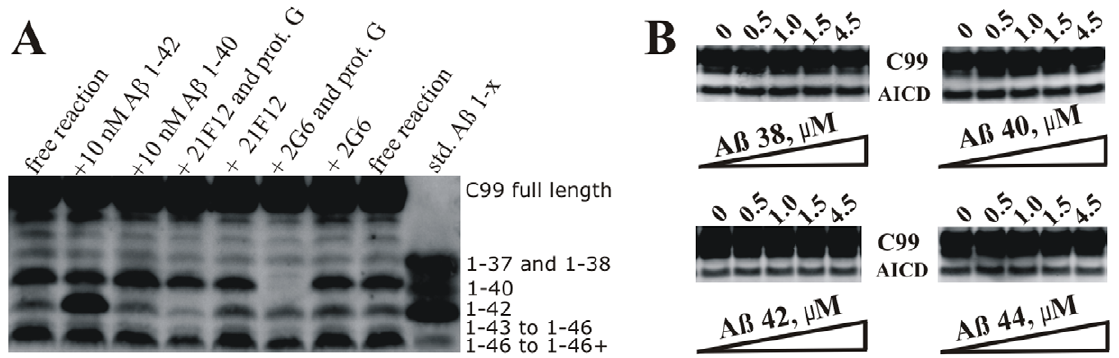
Figure 7. c -Secretase is not affected by A b peptides present in free solution. (A) The lanes labeled as ‘‘free reaction’’ represent A b products after 4 hours of routine c -secretase reaction at half saturating C99 substrate ([C99]=0.45 m M). The lanes labeled as ‘‘ + 10 nM A b 1–42’’ and ‘‘ + 10 nM A b 1–40’’ represent ‘‘free reaction’’ premixed with synthetic A b 1–42 or A b 1–40 in a concentration equivalent that corresponds to 4 hours of free reaction. The lanes labeled ‘‘ + 21F12’’ and ‘‘ + 2G6’’ represent ‘‘free reaction’’ that was premixed with antibodies specific for A b 42 or A b 40 respectively. Both 2G6 and 21F12 antibodies bind the matching A b peptides very efficiently as indicated by a complete removal of the corresponding A b bands in the reactions with protein G beads (samples labeled as ‘‘21F12 and prot. G’’ and ‘‘2G6 and prot. G’’). The lane ‘‘A b std 1-x’’ represents synthetic peptides as mobility standards. (B) AICD production was measured at half-saturating C99 substrate (0.45 m M) in assays that were premixed with increasing concentrations of synthetic A b 1–38, A b 1–40, A b 1–42, or A b 1–44.